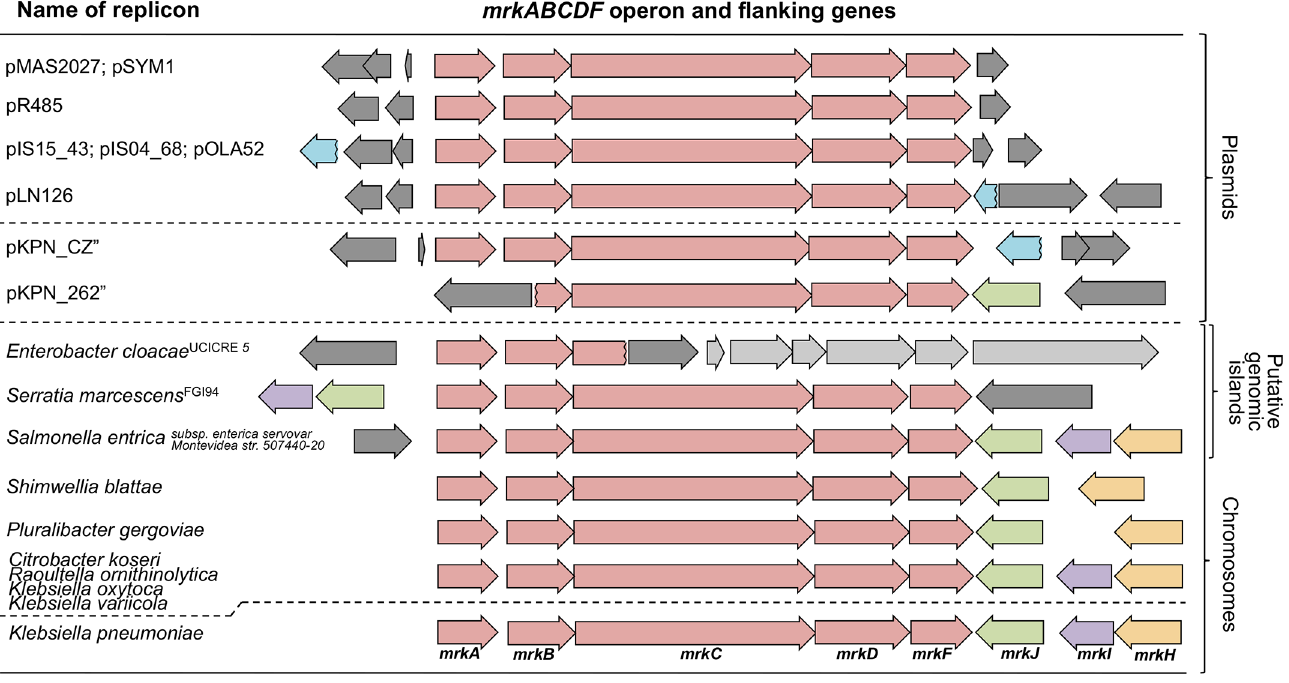
Fig 4. Genetic map of the mrkABCDF operon and flanking putative regulatory elements encoded on all fully sequenced representative replicons available in GenBank. Red: mrkABCDF genes. Orange: mrkH and mrkH L genes. Purple: mrkI and mrkI L genes. Green: mrkJ and mrkJ L genes. Blue: putative genes encoding incomplete EAL domains. Dark gray: IS/transposon elements. Light gray: phage associated genes. ( ” ) Plasmids pKPN_CZ and pKPN_262 have been isolated from Klebsiella hosts while all other plasmids originate from non- Klebsiella hosts.